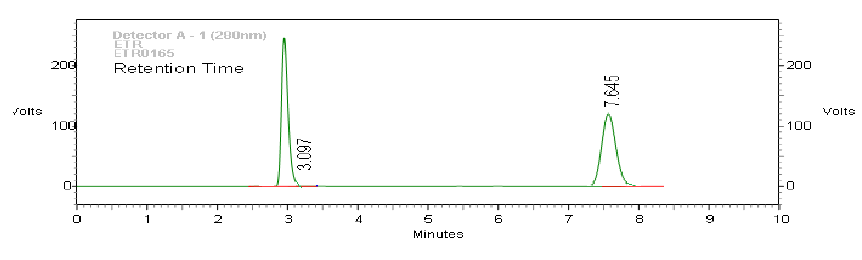
Figure 5: Representative Chromatogram of Etoricoxib Fomulation (ETROBAX - 60 mg) (20 µg ml -1 ) (Rt = 3.097 mins) with Bromohexine (IS) (10 µg ml -1 ) (Rt = 7.645